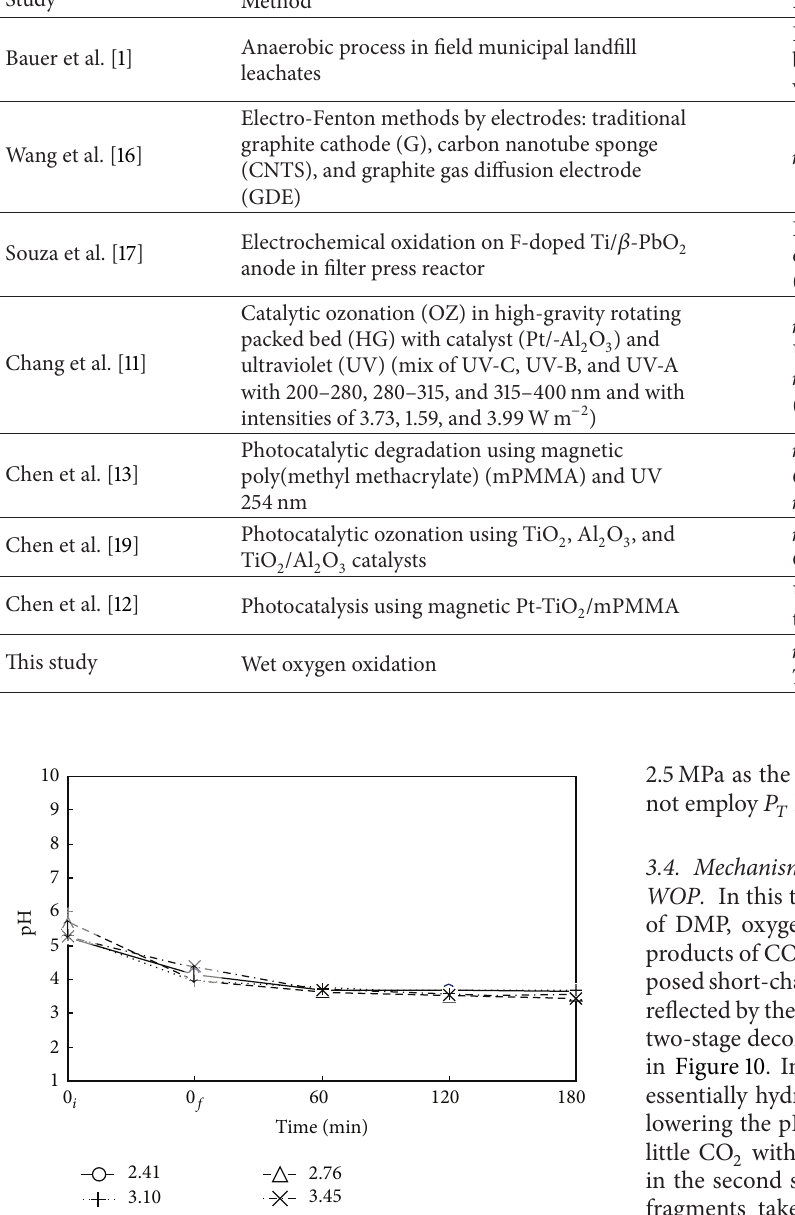
Figure 9: Time variation of pH value for decomposition of DMP via WOP at various pressures. I , △ , +, and × : 𝑃 𝑇 = 2.41, 2.76, 3.10, and 3.45 MPa. 𝐶 0 = 100mg L −1 , 𝑉 𝐿 = 400 mL, 𝑇 = 483 K, and Nr = 500 rpm. Working gas after time = 0 𝑓 is O 2 . ↕ : Mean and Standard deviation (SD, 𝑛 − 1 method) at 𝑡 = 0 𝑖 : 5.2 ± 0.2 and at 𝑡 = 0 𝑓 : 4.1 ±